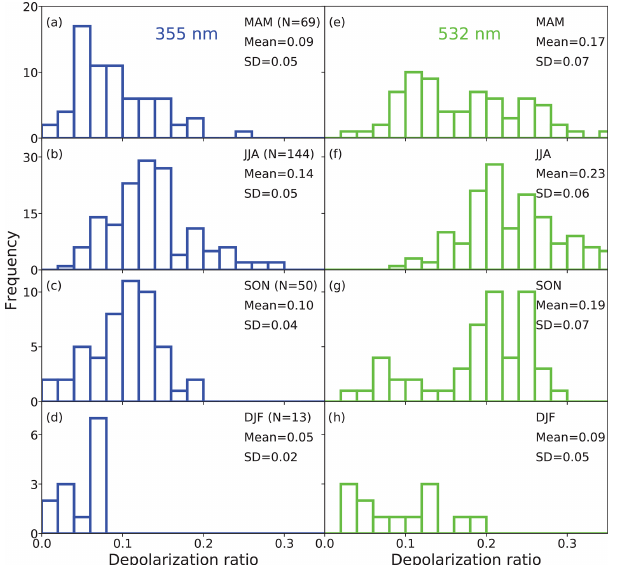
Figure 3. Same as Fig. 2, except for the lidar ratios at 355 and